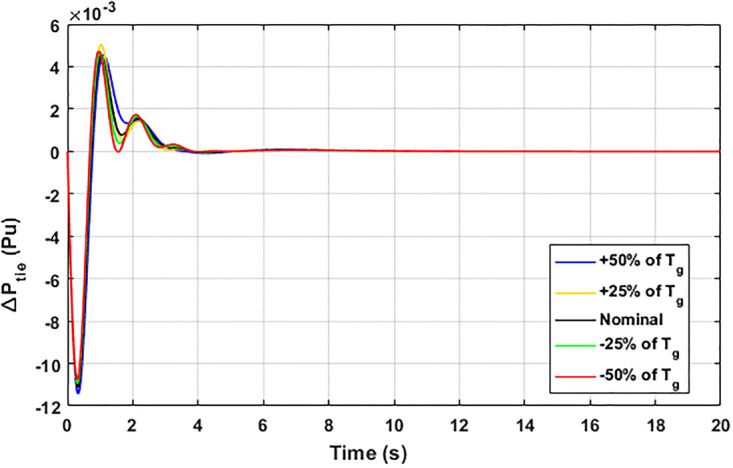
Results for variation in Tg with ΔPtie.